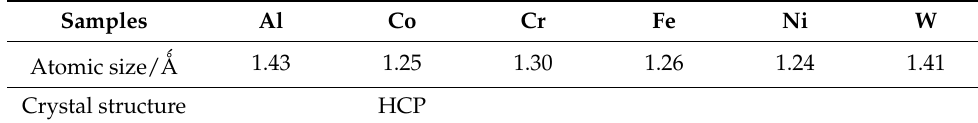
Table 2. Atomic size of HEA coatings’ elements (Al, Co, Cr, Fe, Ni,